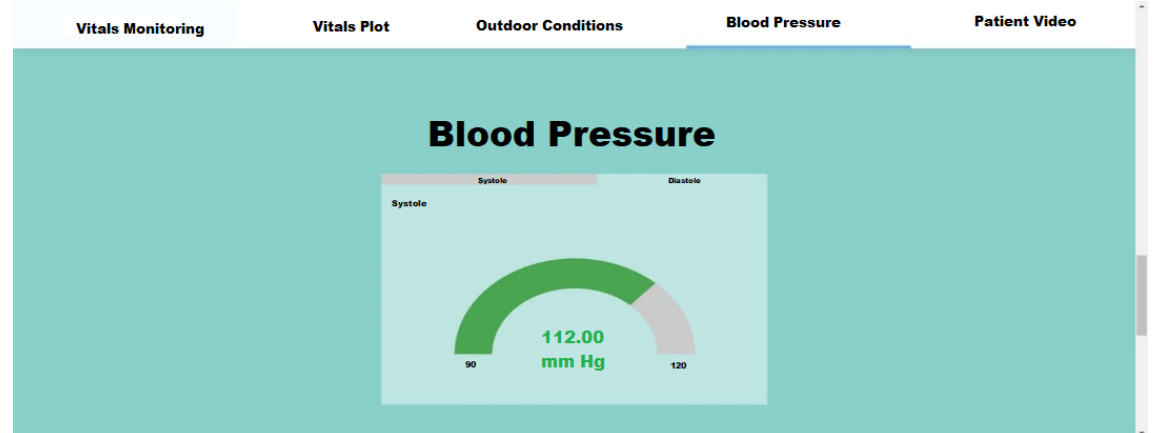
Figure 9. Systolic and diastolic blood pressure displayed on the